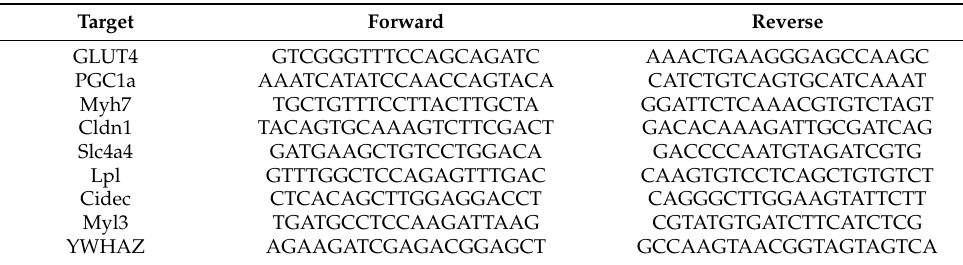
Table 1. Primers used for RT-qPCR